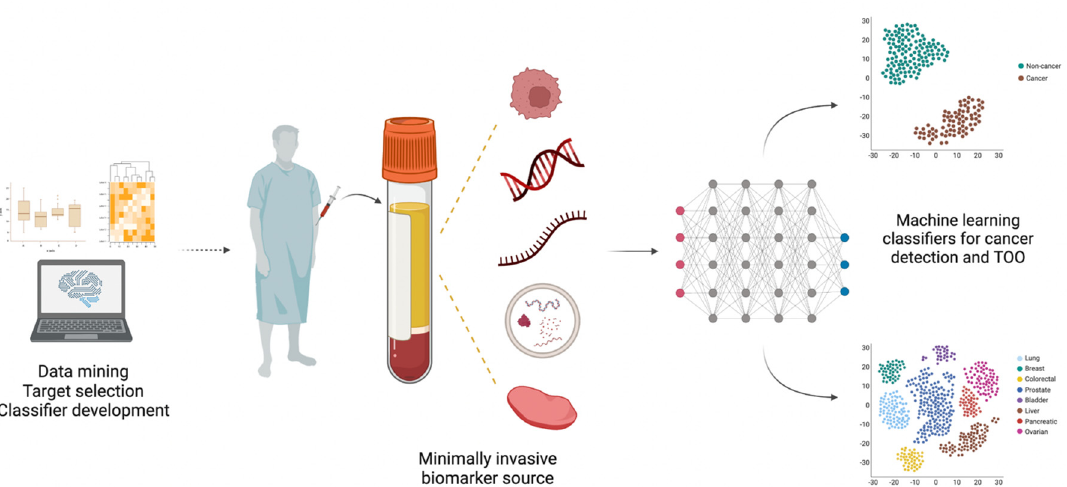
Figure 3. Schematic representation of the workflow for developing multi-cancer early detection tests. Data mining of big datasets, such as TCGA, are great tools for selecting biomarkers with utility for cancer detection. Liquid biopsies provide a minimally invasive way to obtain cancer-related information, namely, circulating tumor cells (CTCs), circulating nucleic acids (cfDNA and cfRNA), extracellular vesicles (EVs), and tumor-educated platelets (TEPs). The molecular analysis of these biomarkers combined with machine learning classifiers shows great potential for detecting multiple cancers simultaneously and discriminating tissue of origin (TOO). Created with BioRender.com.